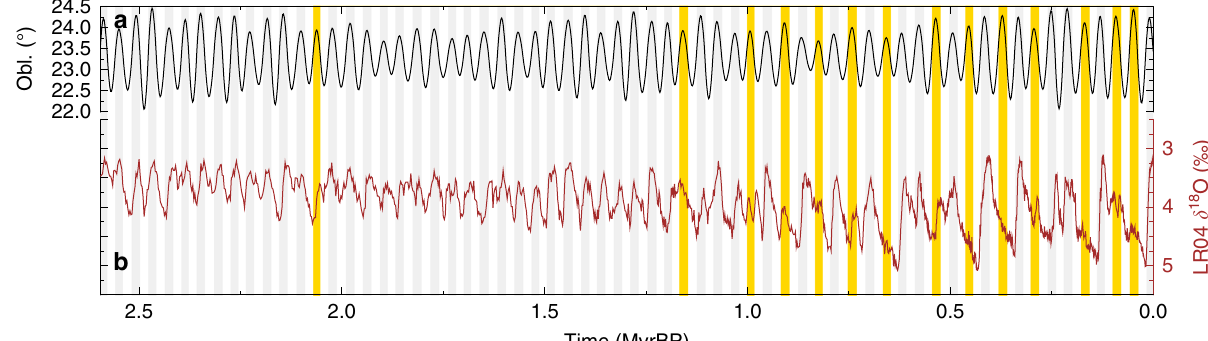
Fig. 1 Obliquity and climate dynamics during the Quaternary. a Obliquity 64 . Obliquity cycles with (without) associated new interglacials as de fi ned in T17 are labelled with grey (gold) vertical bands for times when obliquity is above average (>23.3°). b Integrated climate change contained in the LR04 4 benthic δ 18 O stack (brown line) plotted on an inverse y